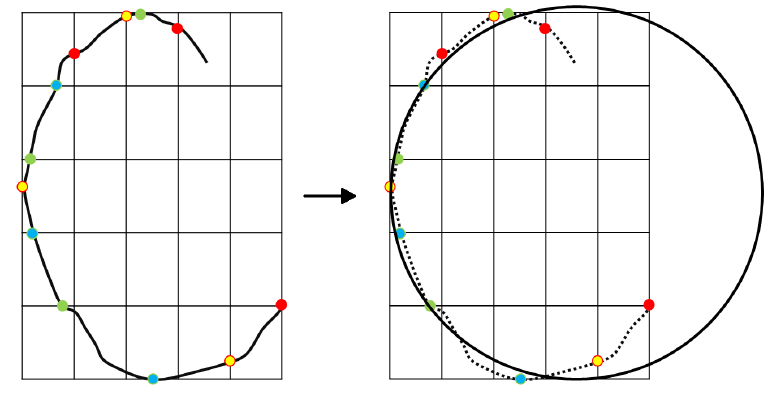
Figure 9. Circle detection algorithm to identify craters’